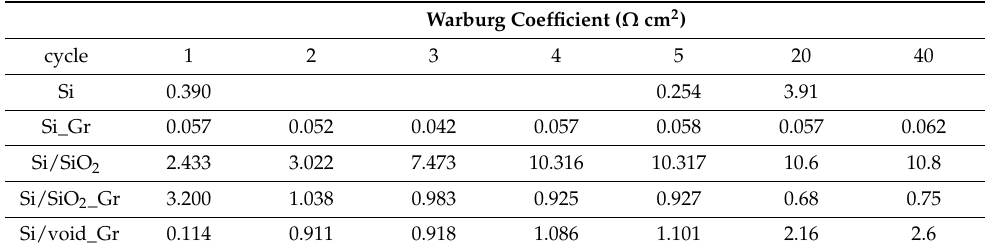
Table 3. Warburg coefficient values for all electrodes extracted from EIS